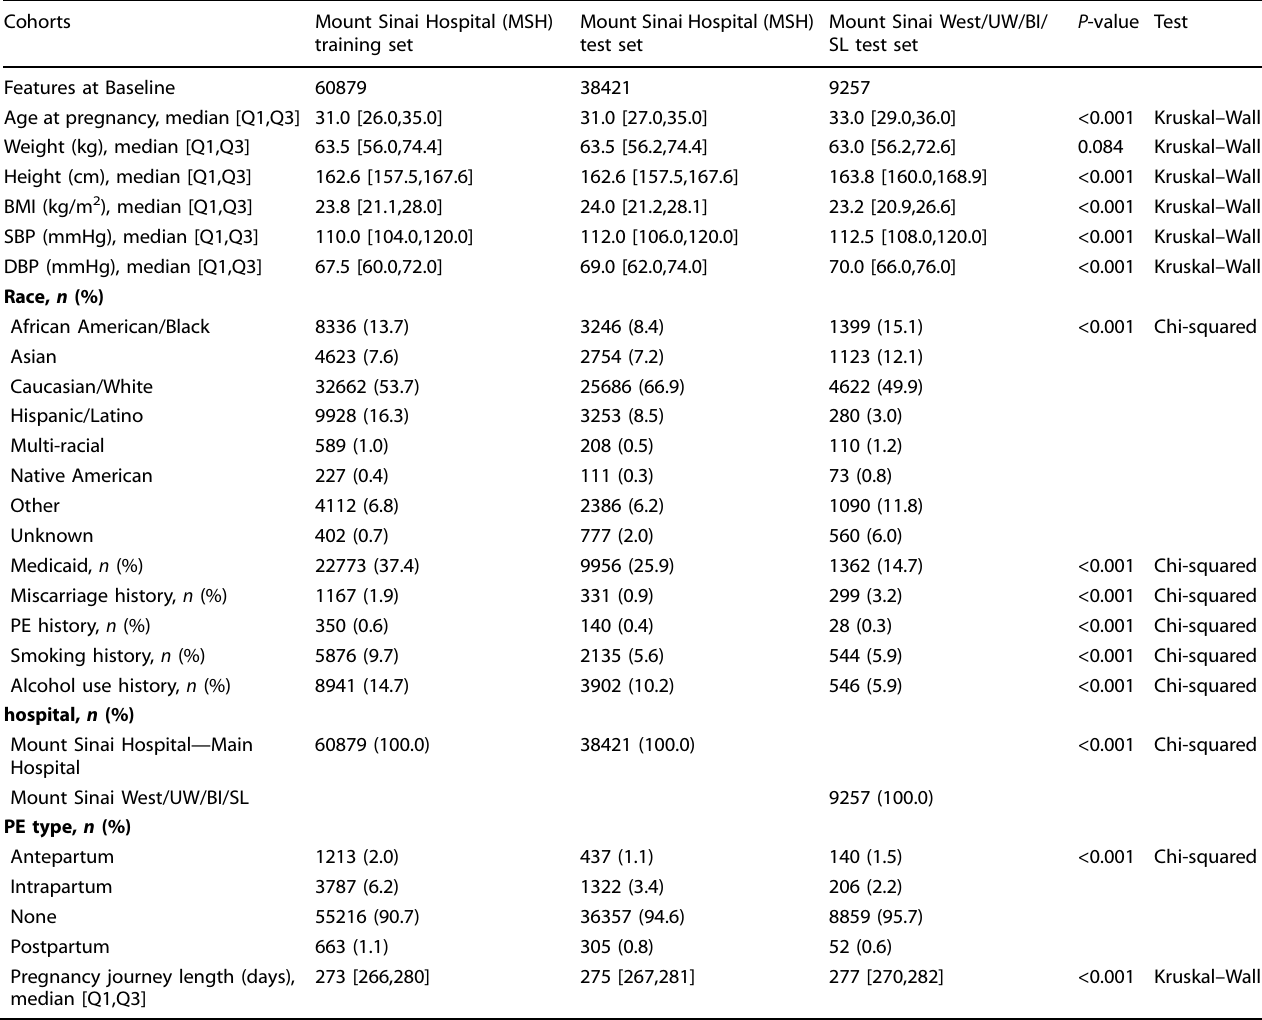
Table 1. Characteristics of patients in MSH training dataset, and MSH and MSW test